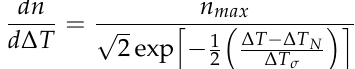
Figure 1. The diagram of the decentered algorithm (